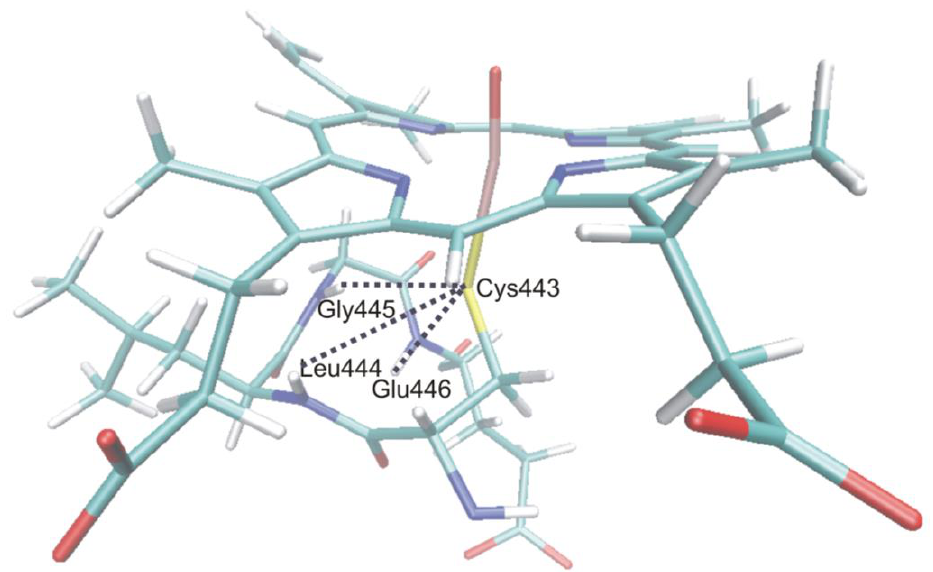
Figure 13. Quantum mechanical/molecular mechanical (QM/MM) optimized snapshot of Compound I with residues hydrogen-bonded to the axial cysteinate in P450